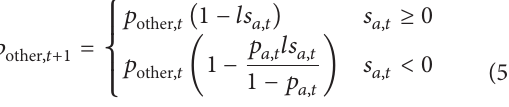
Figure 4: Numerical example in Tian’s